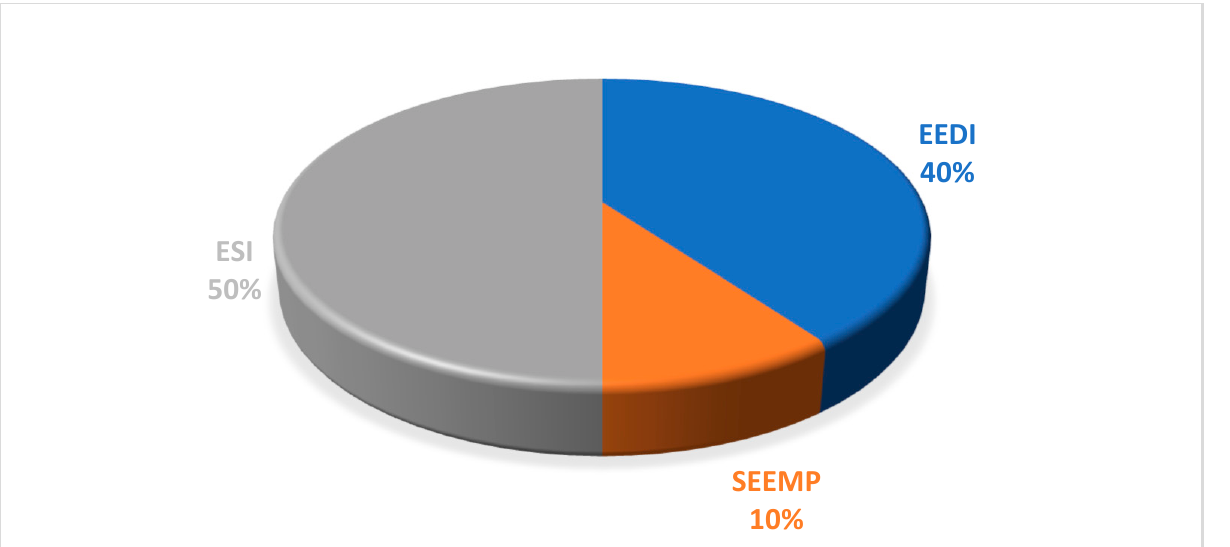
Figure 2. Application of port waste and energy efficiency monitoring indicators in the surveyed ports in Northern Europe. Source: own study.